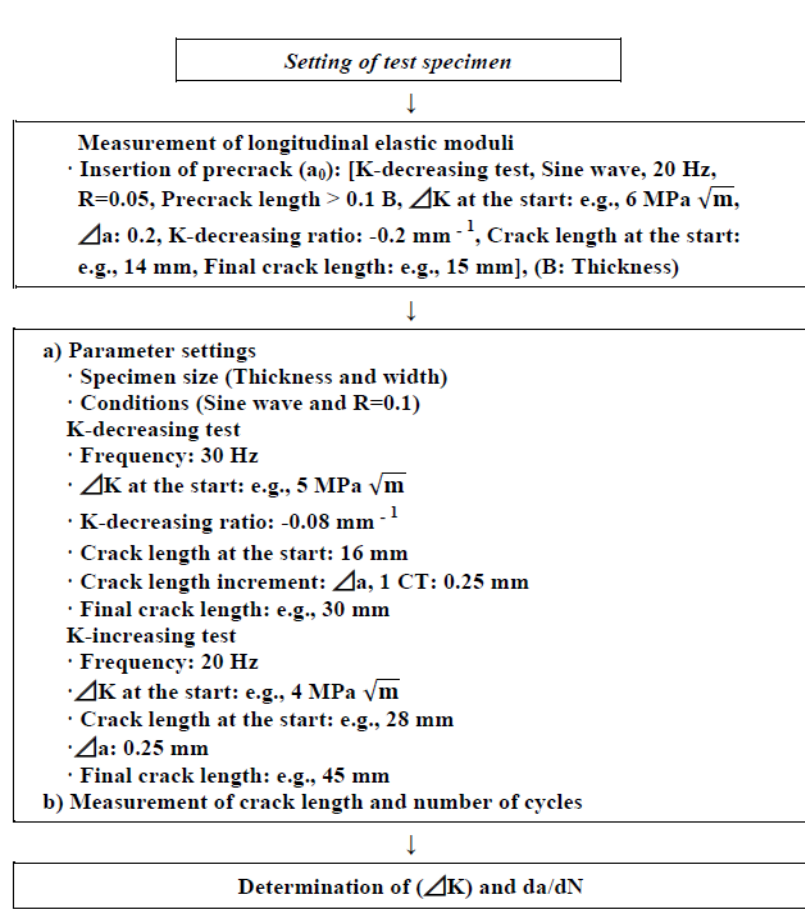
Figure 6. Fatigue crack growth test